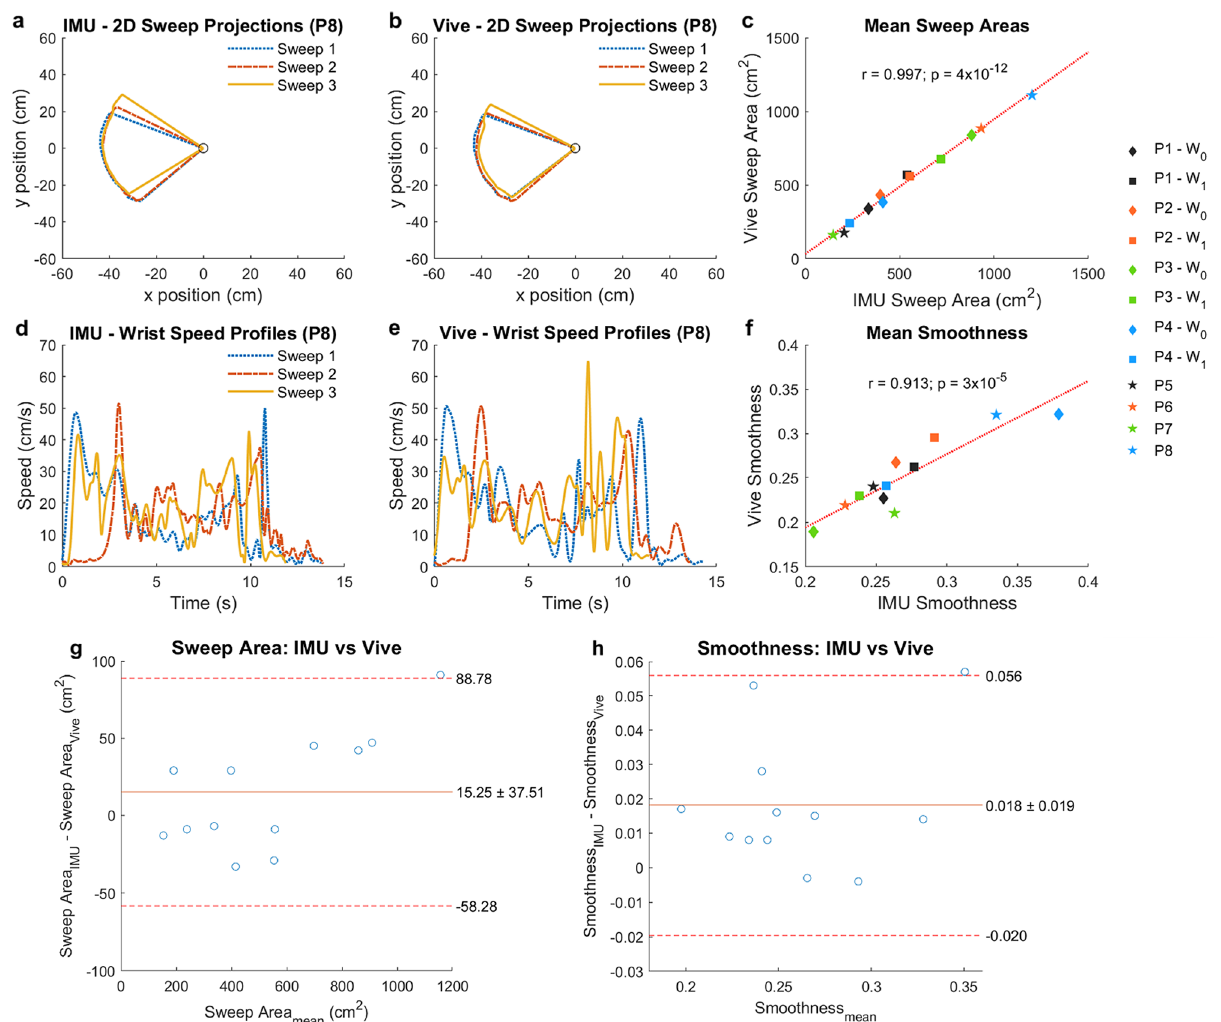
Figure 6. Sweep task kinematic metrics. ( a ) Example traces of the sweep areas estimated by the IMUs in participant 8 (P8). The three sweeps (blue, red, yellow) were projected onto the horizontal plane. ( b ) Example traces of the sweep areas estimated by the Vive. ( c ) Estimated mean sweep areas for all sweep tasks performed by all participants (marker labels to the right of c and f ). Each marker is one mean sweep area. W 0 and W 1 represent the baseline week and the later week, respectively. ( d ) Example traces of wrist speed profiles estimated by the IMUs. ( e ) Example traces of the wrist speed estimated by the Vive. ( f ) Estimated smoothness for all sweep tasks. ( g , h ) Bland–Altman plots comparing the mean ( g ) sweep area and ( h ) smoothness estimated by the IMUs and